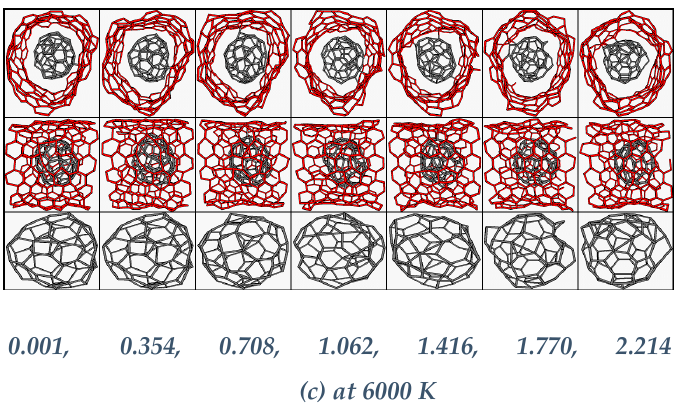
Figure 4. Snapshots of the fragmentation process for the carbon nano-peapod (CNP) at 4000 K in ( a ), 5000 K in ( b ), and 6000 K in ( c ), respectively. Here, the simulation time (unit: picosecond) is of the last row of snapshots in a regular sequence.